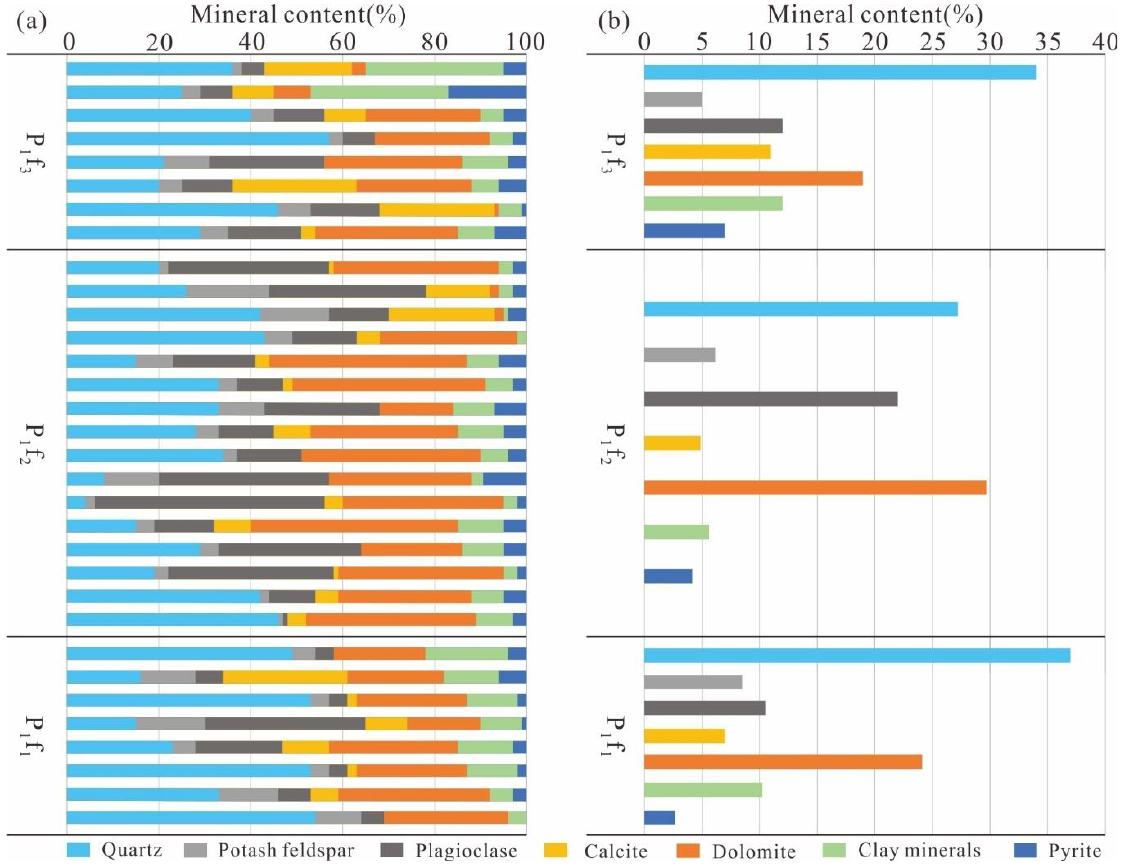
Figure 2. X-ray diffraction analysis of shale of Fengcheng Formation in Mahu Sag: ( a ) Mineral composition of each shale sample; ( b ) Mineral composition of each member.